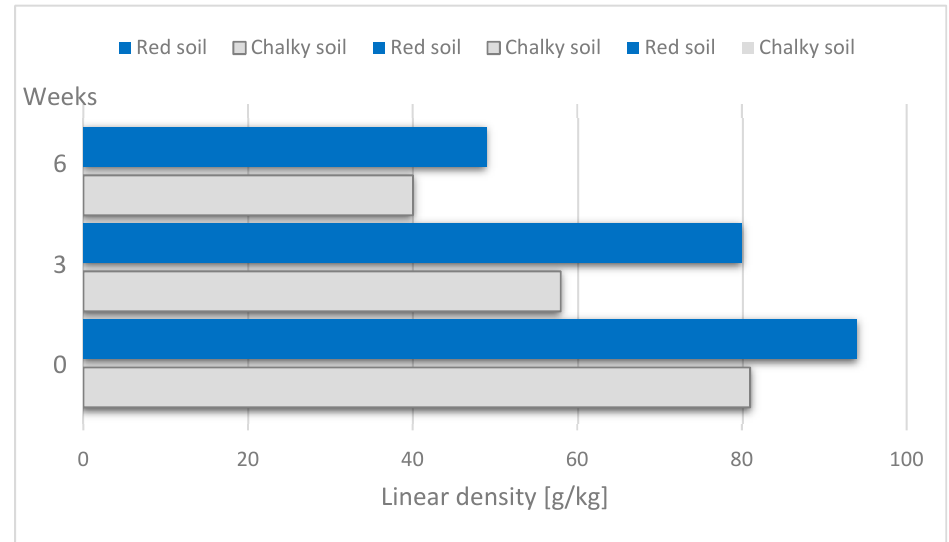
Figure 17. Linear density (g/km) of hemp tow in relation to retting duration, based on [61]. Réquilé [27] confirmed that a hemp retting effect that ensures the required quality of fibres can be achieved by controlling the duration of the retting process conducted in dif-